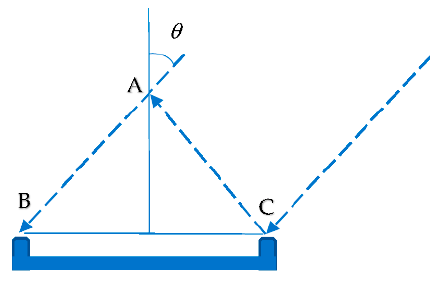
Figure 4. Sound localization schema.